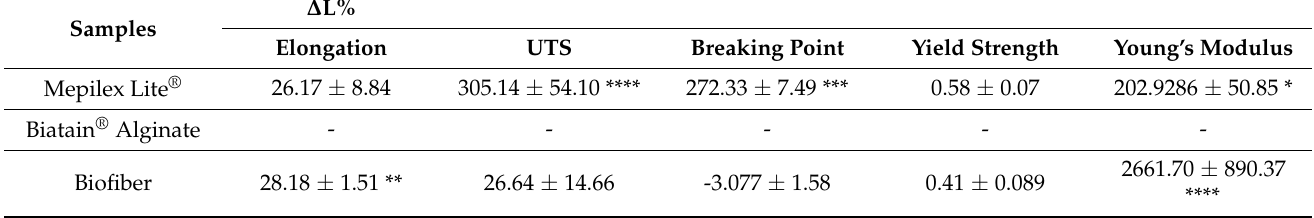
Mepilex Lite ® , Biatain ® Alginate, and Biofiber ∆ L% of dry vs. wet conditions (SWF, 34 ◦ C for 72 h). Statistically significant values are indicated as * p < 0.05, ** p <